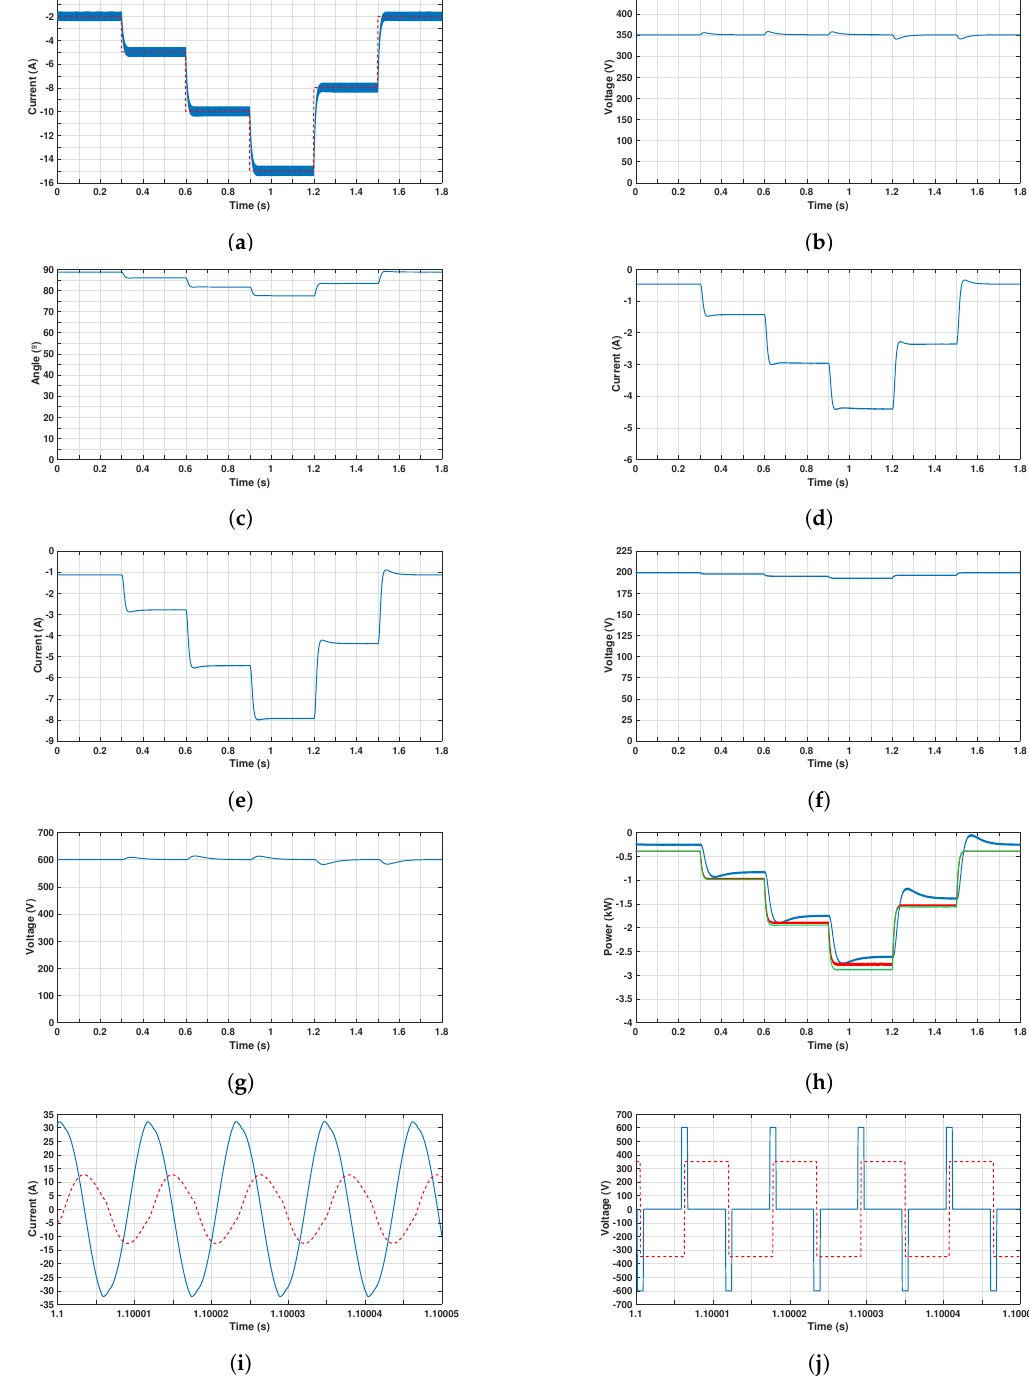
Figure 16. Results obtained for the V2G mode when k = 0.7 k n . Time responses of: ( a ) the battery current (red); ( b ) the DC voltage v DC 2 ; ( c ) the phase-shift angle α ; ( d ) the current i in ; i b (blue) and the reference i ∗ b ( e ) the current i 0 ; ( f ) the voltage of the battery v b ; ( g ) the DC voltage v DC 1 ; ( h ) the grid power P g (blue), the power at the input of the DC–DC converter P dc (red) and the battery power P b (green); ( i ) currents of the compensated magnetic coupler i 1 (blue), and i 2 (red); ( j ) voltages across the compensated magnetic coupler v 1 (blue), and v 2